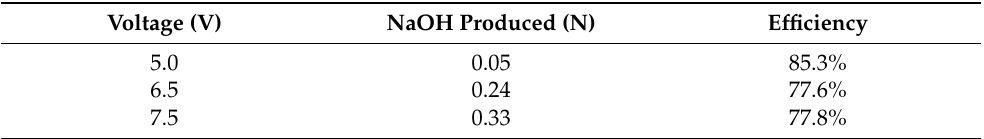
Figure 9. Evolution of current intensity with electrolysis time at 25 ◦ C and 0.01 N. The efficiency for each experiment was carried out at 25 ◦ C, an initial concentration of 0.01N NaOH, a workflow of 400 mL/min, and a NaCl concentration of 40 g/L. This current efficiency is presented in Table 2. Table 2. Current efficiency.